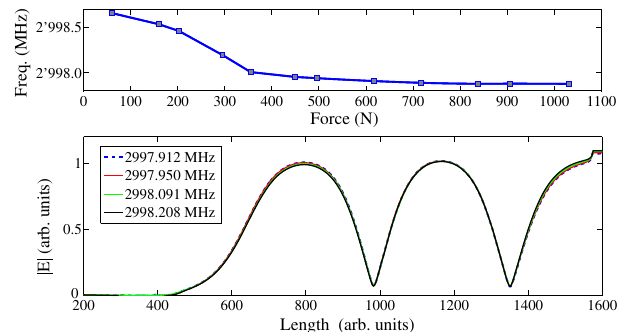
FIG. 13. Resonant frequency of the π -mode as a function of the force applied to the cathode plug (top). On-axis electric field profiles for different frequencies, obtained by varying the position of the cathode plug (bottom).